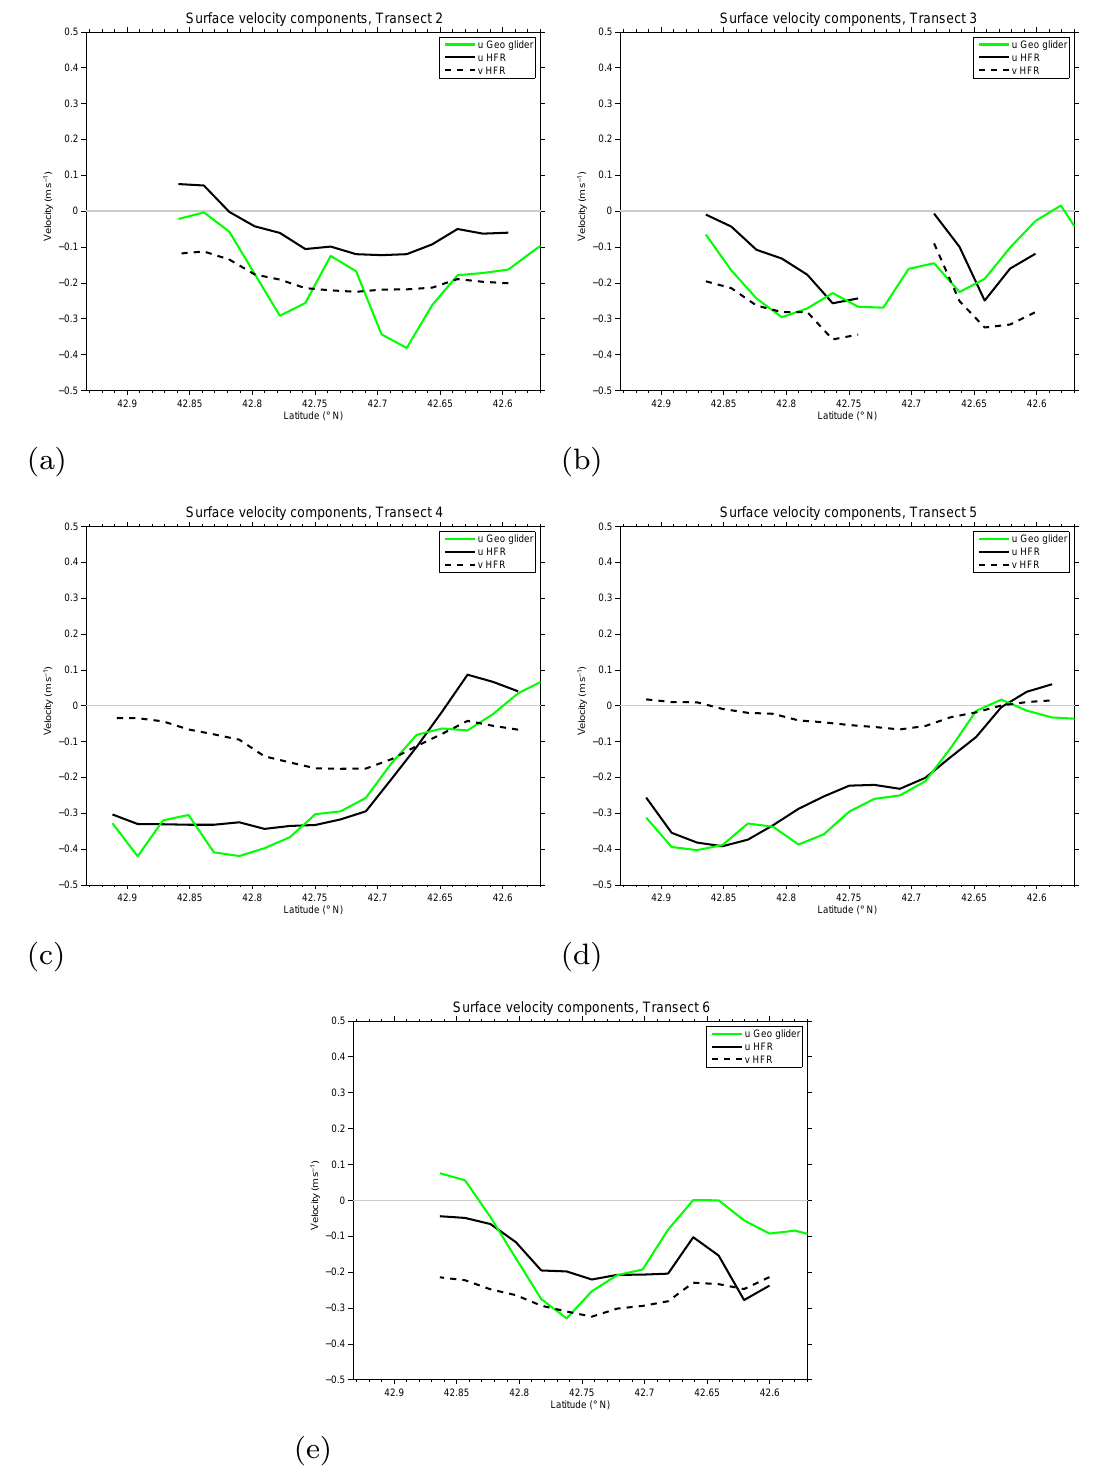
Figure 9. Comparison of u S (solid black line) and v S (dashed black line) components of total surface currents from HFR and u Sg (green line) geostrophic component from glider transects. Positive u(v) currents are eastward (northward), and the gray line indicates null velocities. Panels (a) to (e) represent measurements during Transects 2 to